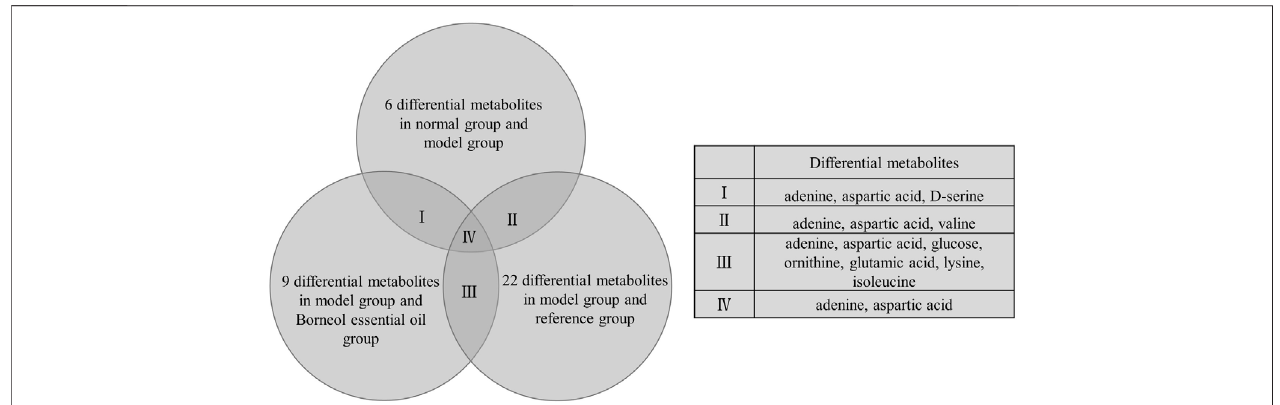
FIGURE 6 | Differential metabolites repeated in brain tissue